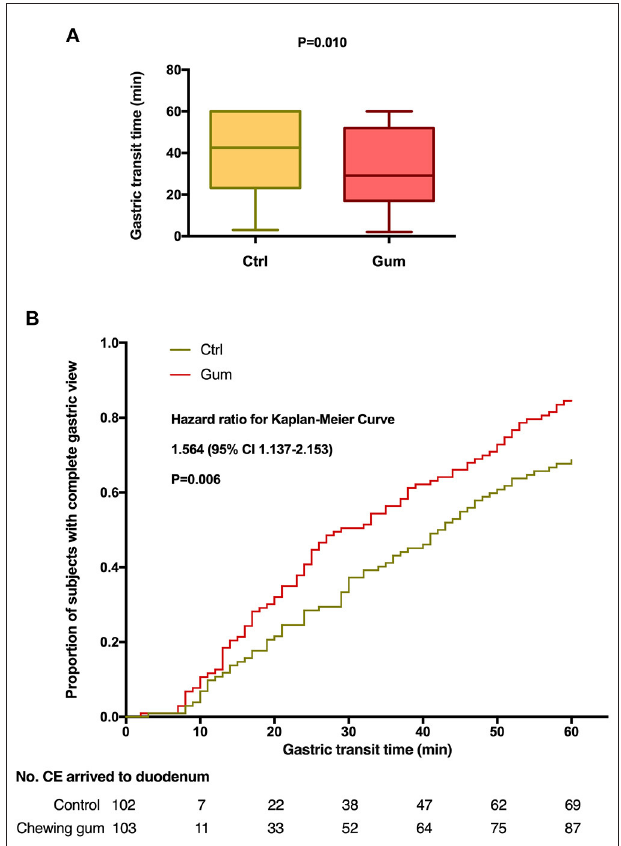
FIGURE 2 | Gastric transit time during capsule endoscopy in the chewing gum group and control group. (A) A boxplot with medians and quartiles; (B) Kaplan–Meier curves for time to complete gastric